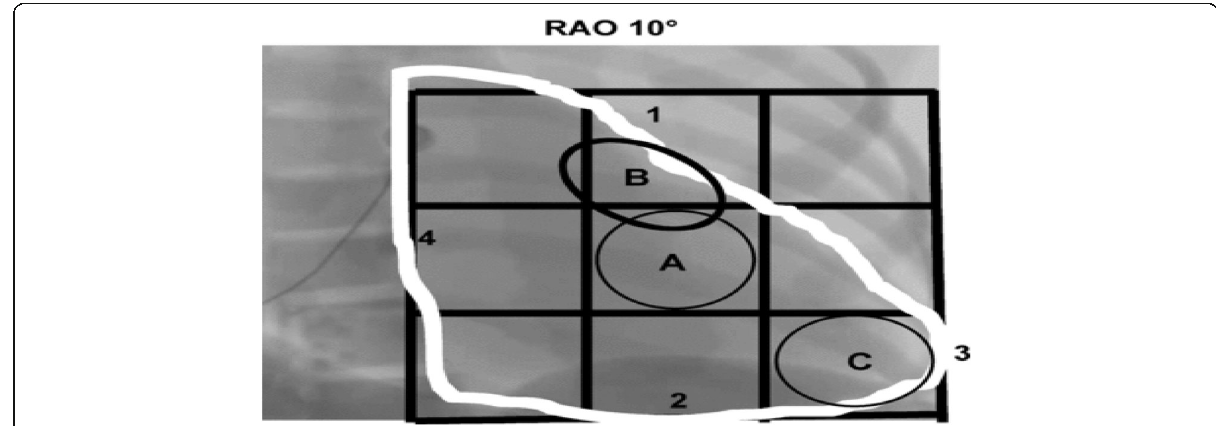
Fig. 1 RAO view circles A and B show the approximate location of the septal lead in optimize RV and protect pace, respectively. Circle C shows the approximate location of the RV apical